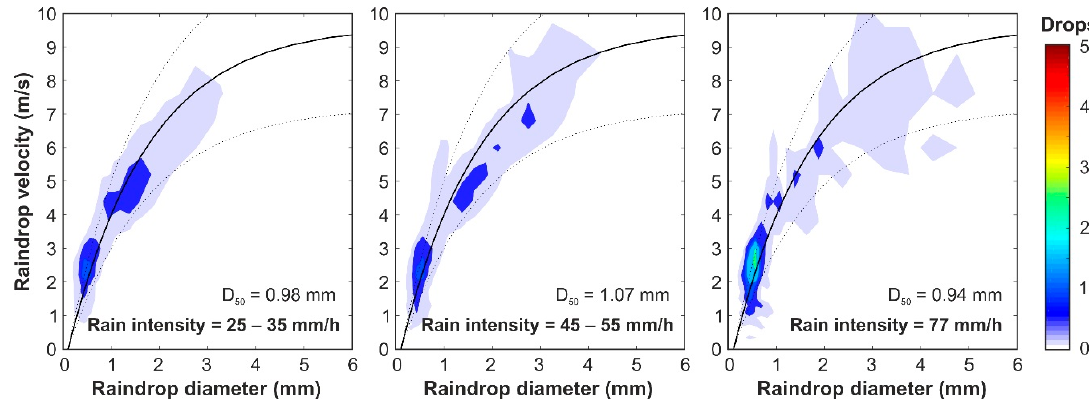
Figure 5. Raindrop size and velocity distribution of natural rainfalls with intensities ranging from 25 to 35 mm/h (33 measurements), 45 to 55 mm/h (8 measurements) and a measurement of 77 mm/h, respectively. The mean of the raindrops registered by the disdrometer classified in sizes and velocities is compared with experimental relation between diameter and terminal velocity [37], which is represented by the solid curve and its 25% of variation by the dotted curves.